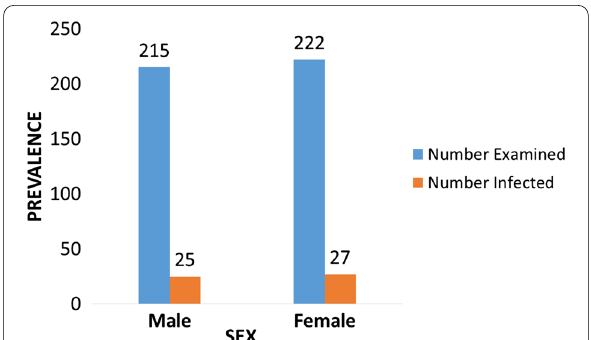
Fig. 2 The Prevalence of Cryptosporidium oocysts in relation to